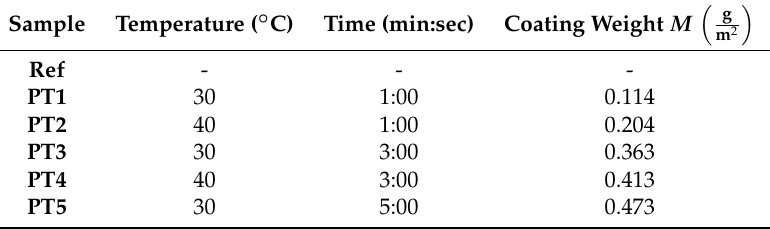
Table 2. Different passivation steps by altering the immersion time and temperature for each sample and the resulting coating weight M